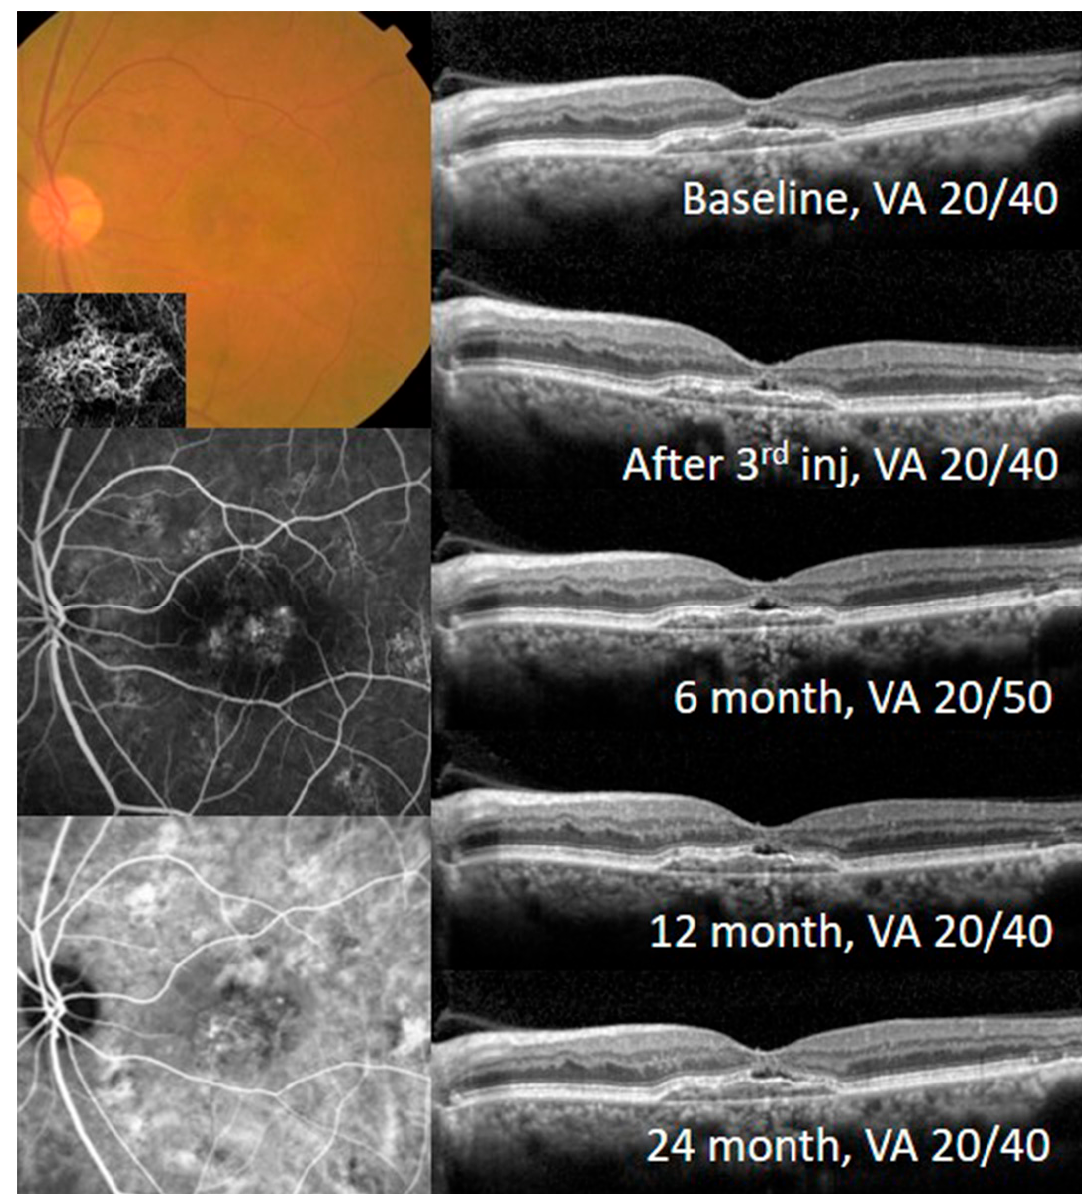
Figure 3. Fundus photography, fluorescein angiography (FA), indocyanine green angiography (ICGA), optical coherence tomographic angiography (OCTA) and optical coherence tomography (OCT) images of the representative case from the fibrovascular PED group. The eye of a 67-year-old male in the fibrovascular PED group was treated by a treat-and-extend regimen with aflibercept during the 2-year follow-up. Tangled choroidal neovascularization in the pigment epithelial detachment (PED) was detected by FA, ICGA, and OCTA. The subretinal fluid was observed by OCT during the follow-up period.